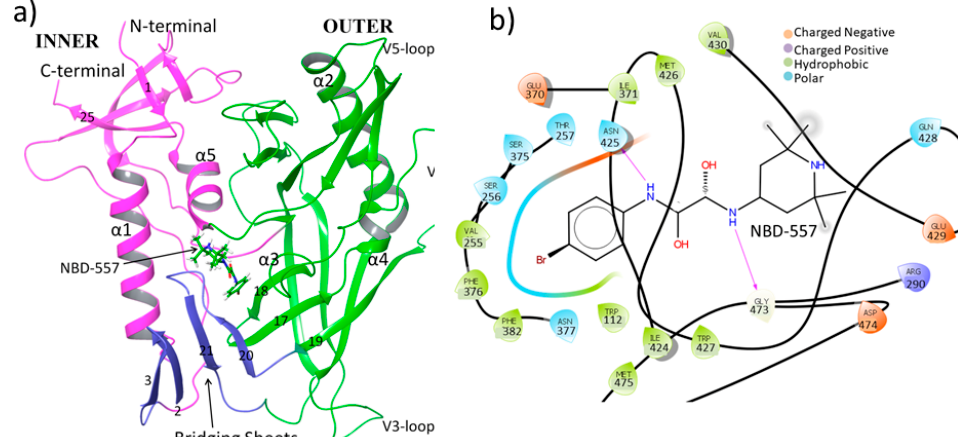
Figure 1. ( a ) Three-dimensional structure of gp120 with structural topology. The inner domain is shown in pink, the outer domain is shown in green, while bridging sheets are shown in blue colors. Numbering of β -sheets is taken from ref. [11] and only a few of them are shown to maintain minimalism in the figure. ( b ) Two-dimensional ligand interaction diagram of gp120 from the crystal structure [20]; H-bonds are shown by pink arrows.